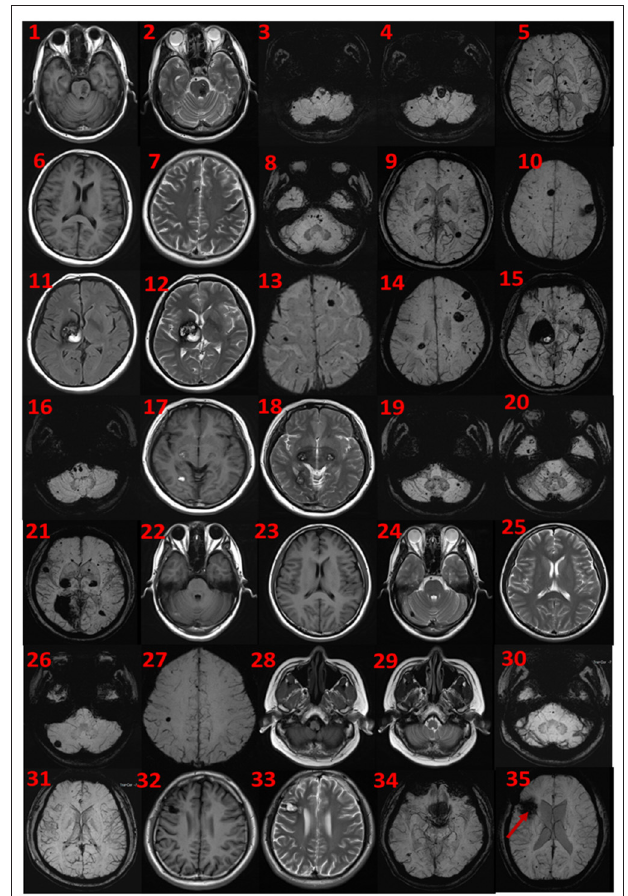
FIGURE 2 | MRI findings. Cerebral MRI in subjects II-1 (1–5), II-4 (6–10), II-6 (11–16), II-8 (17–21), III-2 (22–27), III-3 (28–31), and iii-4 (32–35). 1–5 the MRI imaging showing there are multiple lesions in bilateral cerebellar hemispheres, brainstem area, left thalamus, and white matter areas in both cerebral hemispheres. 6–10 the MRI imaging showing there are multiple lesions in the brain stem and bilateral cerebral hemispheres. 11–16 the MRI imaging showing there are multiple lesions in the cerebellum, brainstem, and bilateral cerebral hemispheres, the large lesions are located in the right basal ganglia area, with a slight space–occupying effect. 17–21 the MRI imaging showing there are multiple lesions in bilateral cerebellar hemispheres, brainstem, bilateral thalamus, and bilateral cerebral hemispheres. 22–27 the MRI imaging showing there are lesions in the right cerebellar hemisphere and the right parietal lobe. 28–31 the MRI imaging showing there are multiple lesions on both sides of the brain, and the arrow points to the postoperative manifestations. 33–35 the MRI imaging showing there are multiple lesions in the brain stem and bilateral cerebral hemispheres.